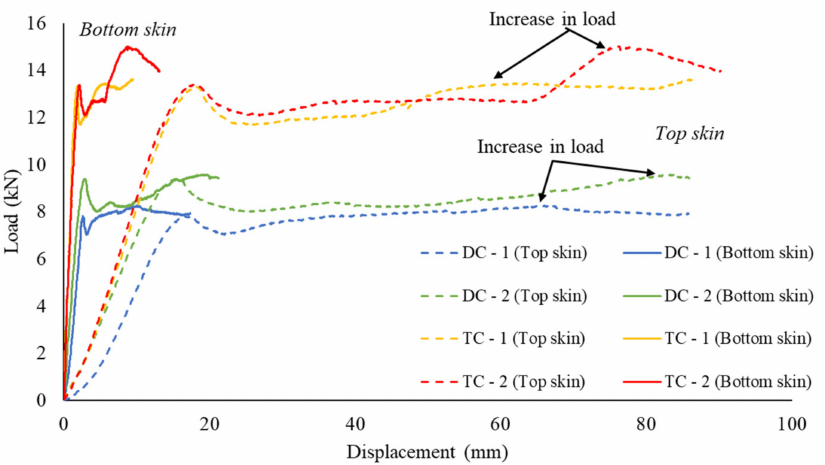
Figure 6. Load vs. displacement of multi-cell panels.